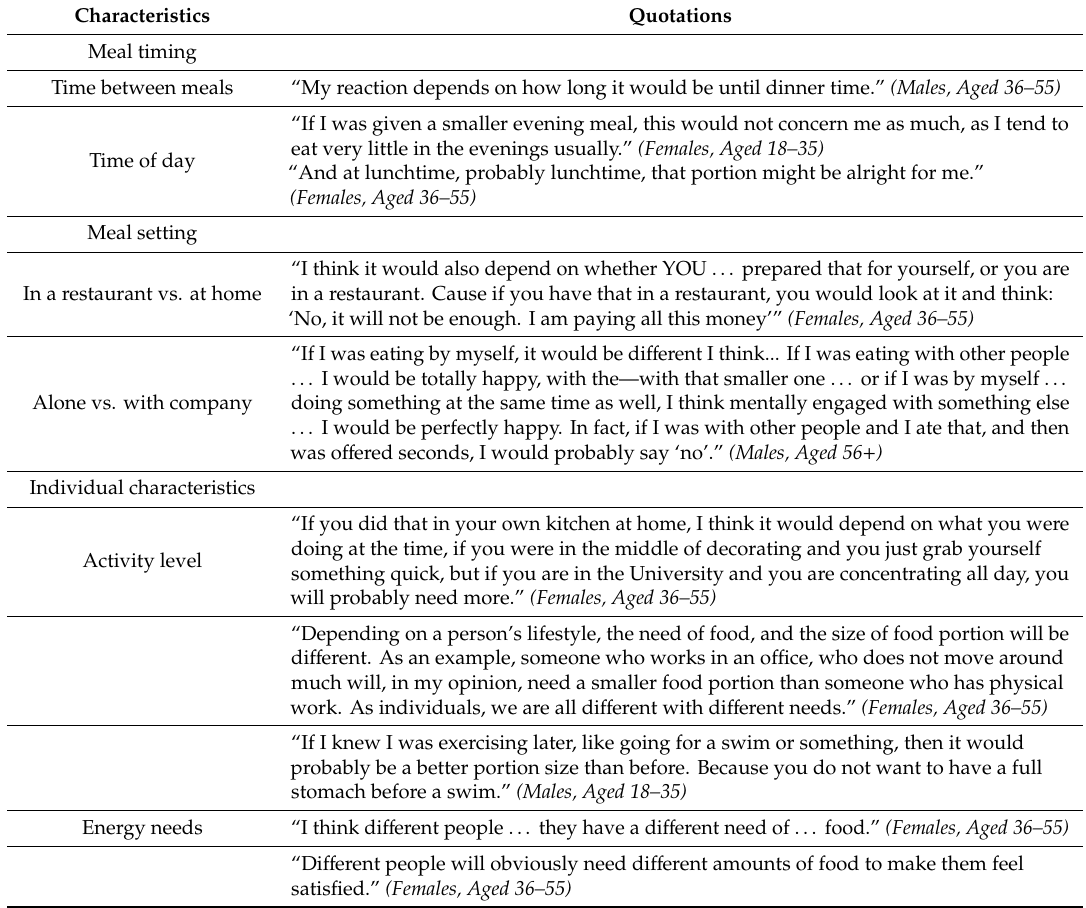
Table 2. The feasibility of feeling satisfied with a 25% smaller portion depended on characteristics of the meal and the individual. The themes included below were discussed by both genders and more than one age